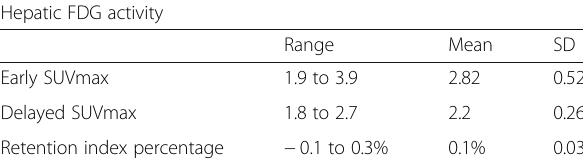
Table 6 Descending thoracic aorta FDG dual point quantitative parameters in the 50 patients of study population